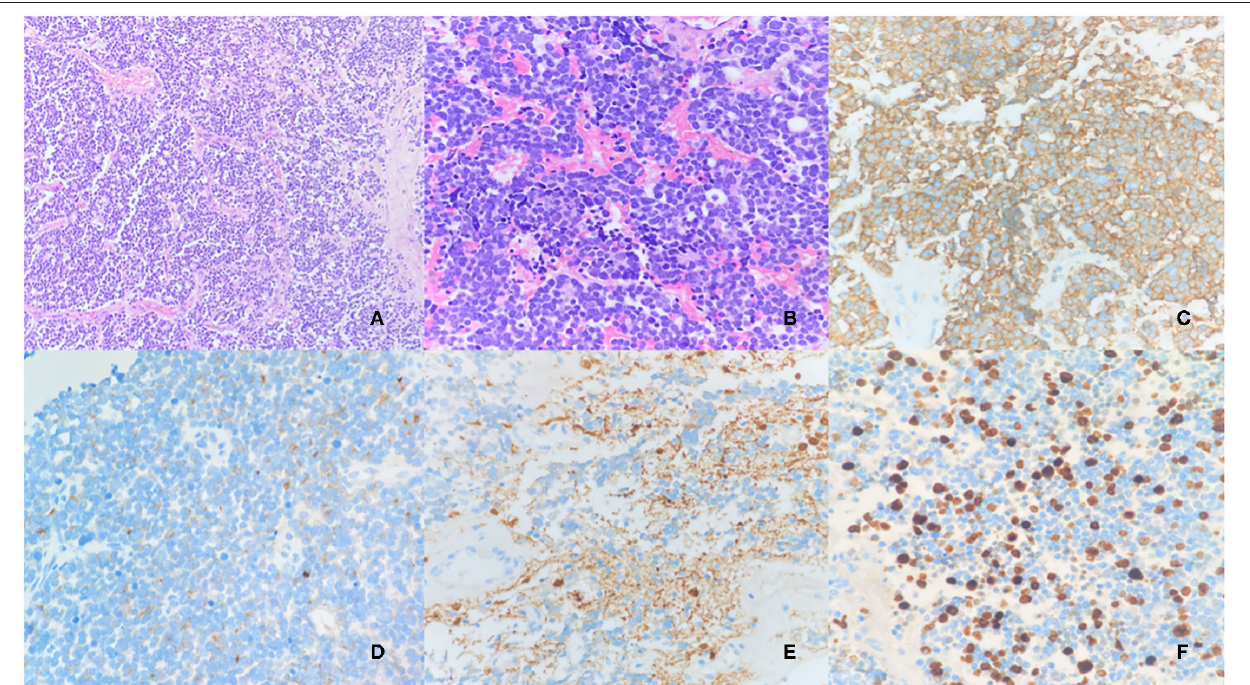
FIGURE 2 | Olfactory neuroblastoma (Hyams III). Proliferation of cells forming lobe sketchs, separated by vascular and hylinized fibrous stroma. HE 10x (A) . The cells are hyperchromatic, pleomorphic, and sometimes arranged in gland-like rings or tight annular formations with a true lumen (Flexner–Wintersteiner rosettes). Some mitotic figures can be seen. HE 20x (B) . Immunohistochemical stains: Synaptophysin (C) ; Chromogranin (D) ; S100: positive in sustentacular periphery cells (E) ; Ki-67 (F) .